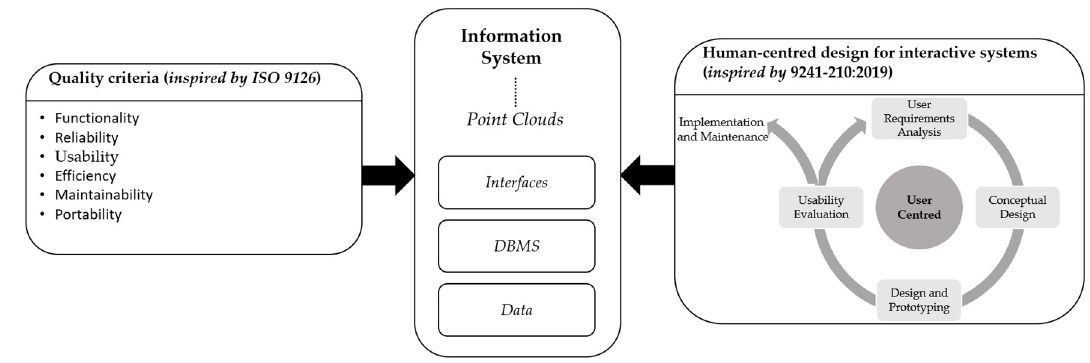
Figure 5. Methodological approach of user ‐ centred and quality information system design.